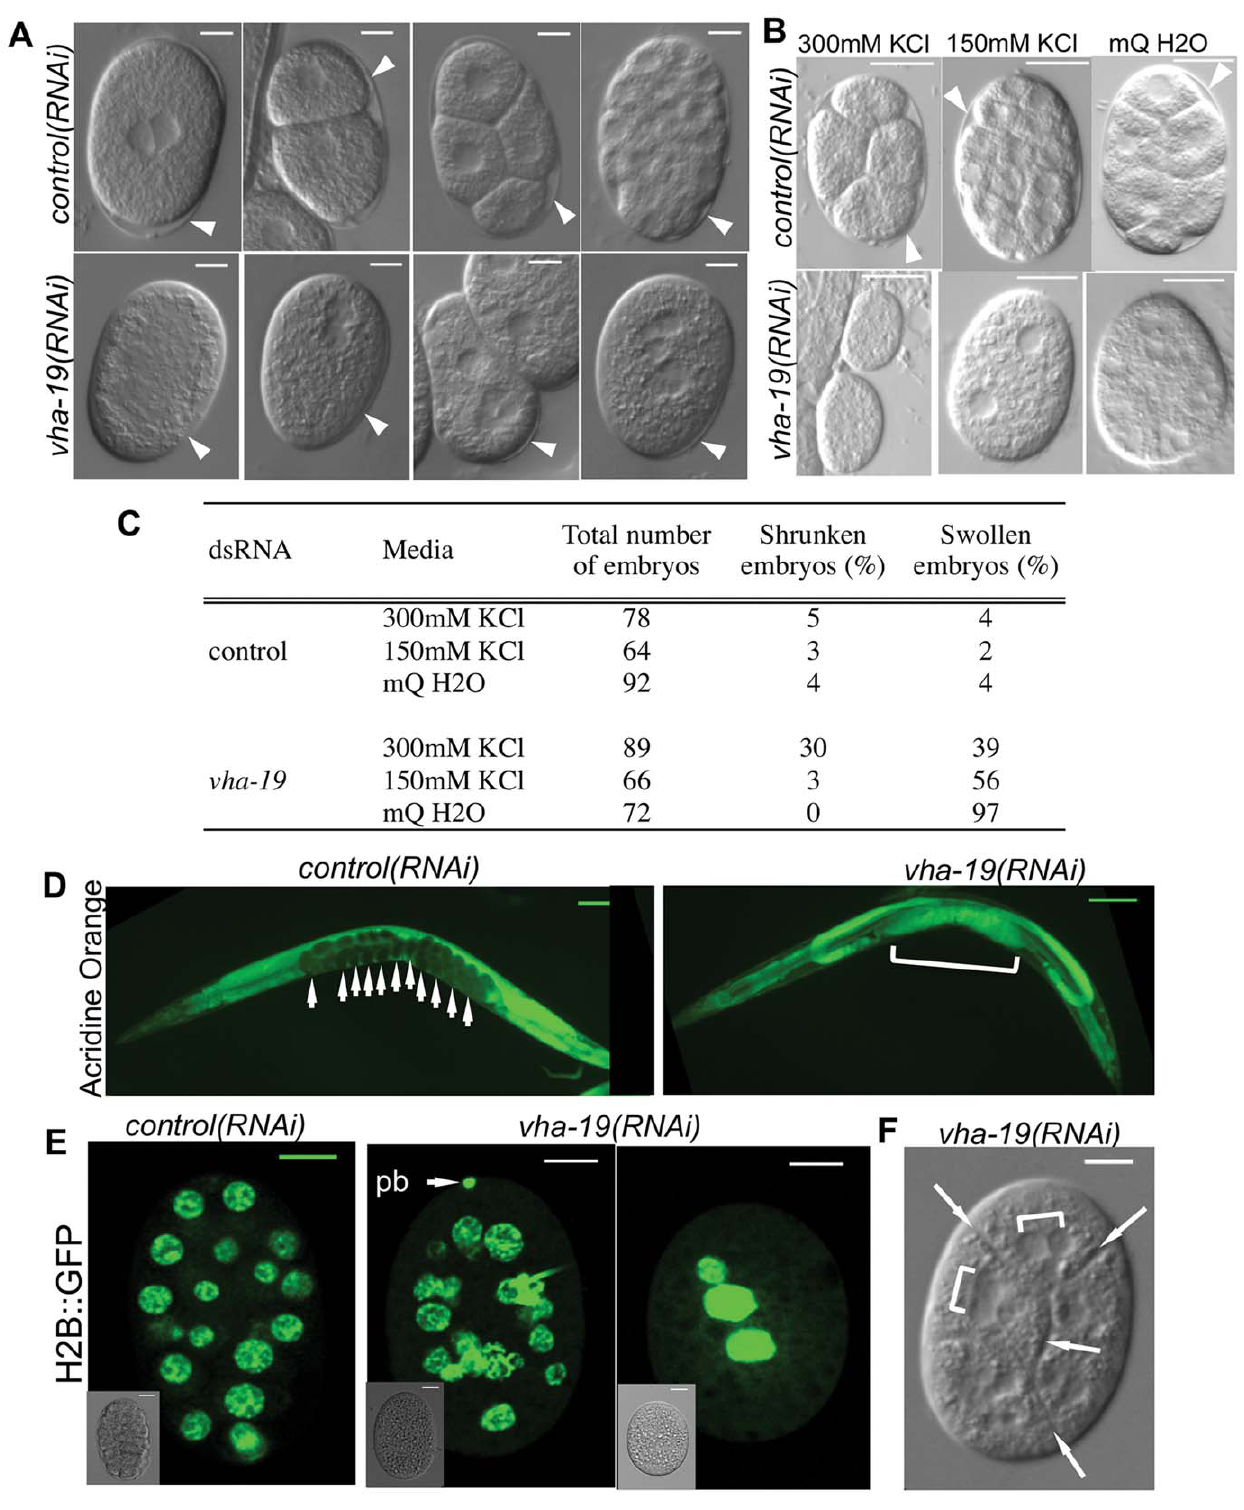
Figure 4. vha-19(RNAi) embryos are osmotically sensitive and appear to have a cytokinesis defect. A) Embryos cut out of the uterus of wild type (A-B,F) or pie-1::H2B::GFP [AZ212] (E) adult C. elegans fed control or vha-19 dsRNA for 24 hours. Note the presence of an eggshell in all embryos in A (arrow heads), despite the random clusters of nuclei and compression of some vha-19(RNAi) embryos. Note also the presence of a polar body (pb) in a vha-19(RNAi) embryo in E, even though the nuclei are not cellularized (inset, bright field image), and that in F, non-cellularized, small clusters of nuclei (square bracket) are surrounded by cleavage furrows (arrows) in the vha-19(RNAi) embryo. C) The percentage of control(RNAi) and vha-19(RNAi) embryos that swelled or shrunk in deionized water (mQ H2O), 150 mM potassium chloride (KCl) and 300 mM KCl. Examples of embryos from this osmolarity experiment are shown in B. D) Embryos in the uterus of adults fed control or vha-19 dsRNA for 48 hours and stained with